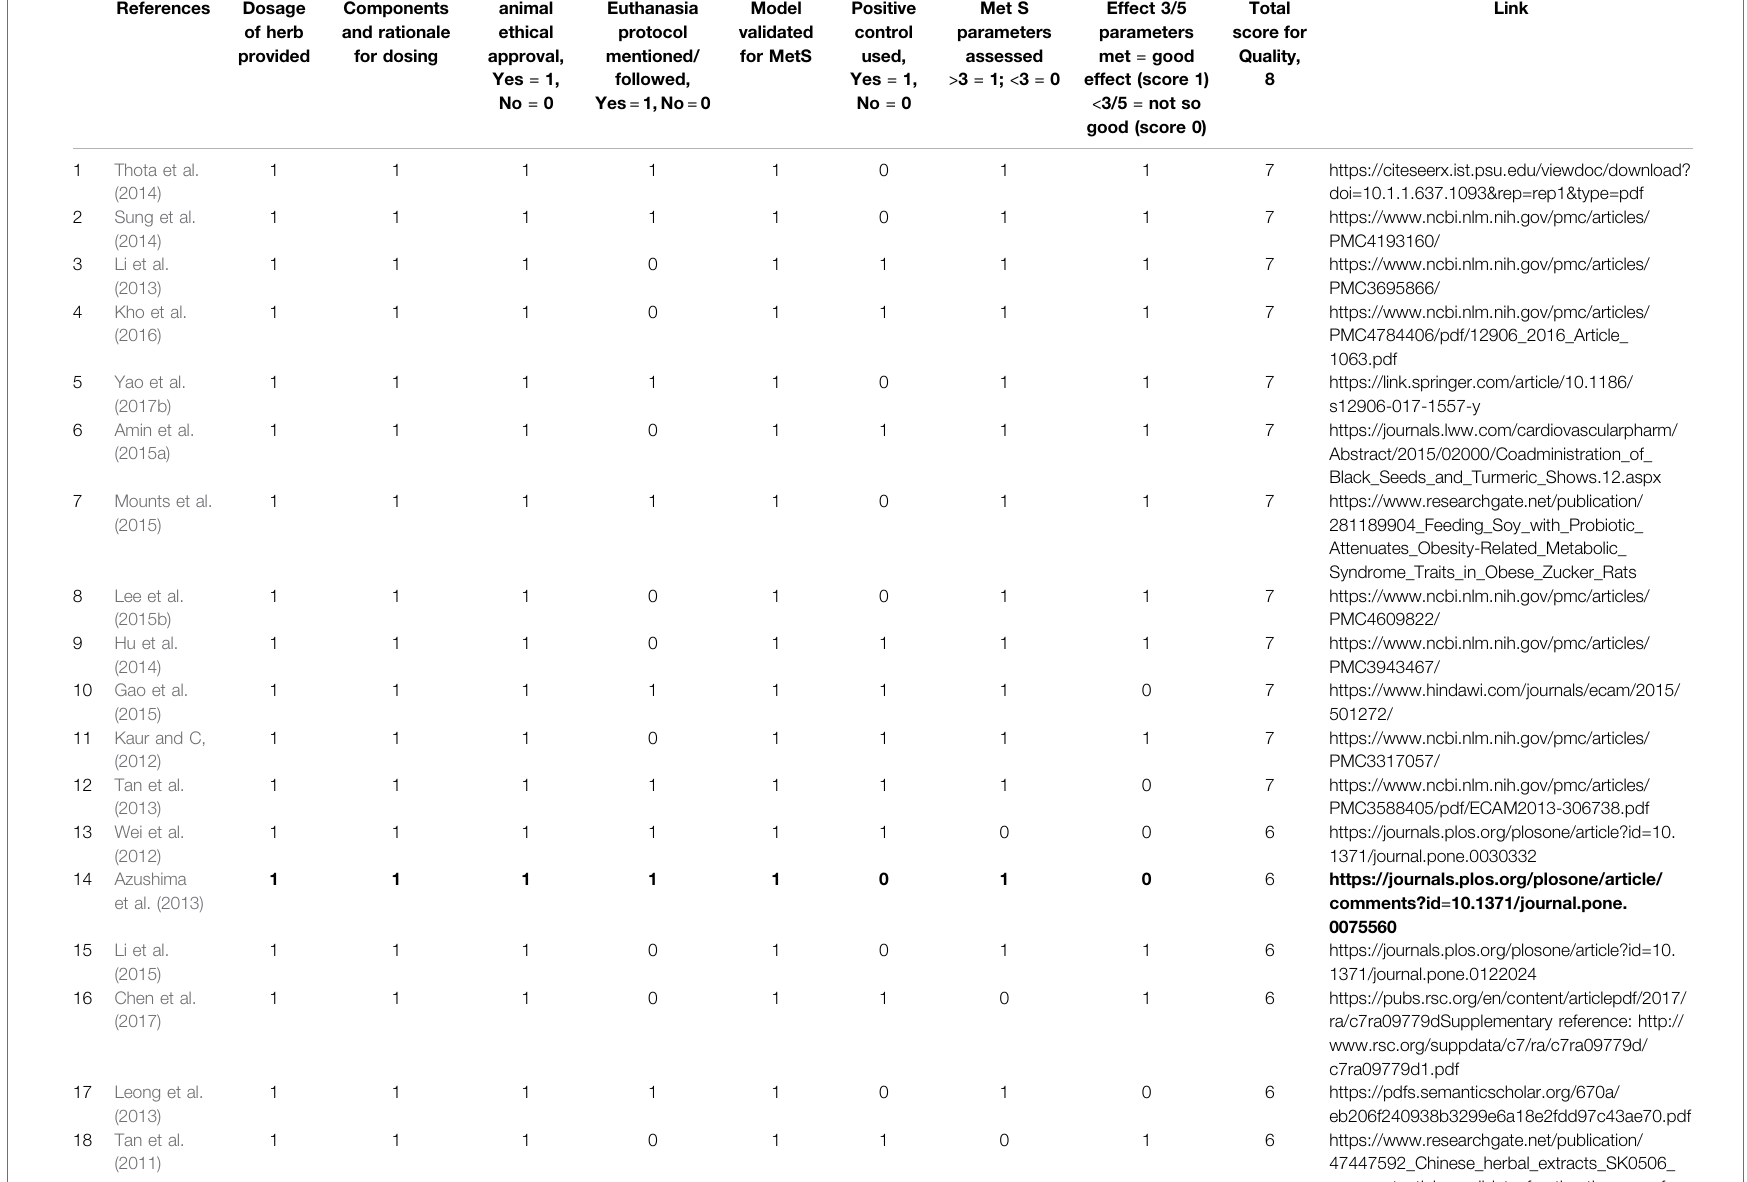
TABLE 4 | Qualitative scoring of studies on polyherbal combinations used in animals of Metabolic Syndrome